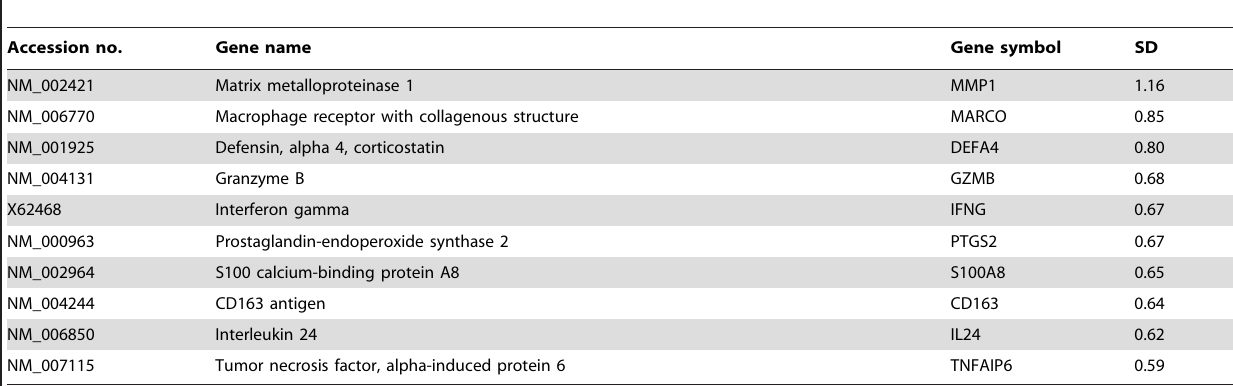
Table 2. The top 10 most variable genes between subjects by stimulation with LPS and the standard deviation (SD) of each.